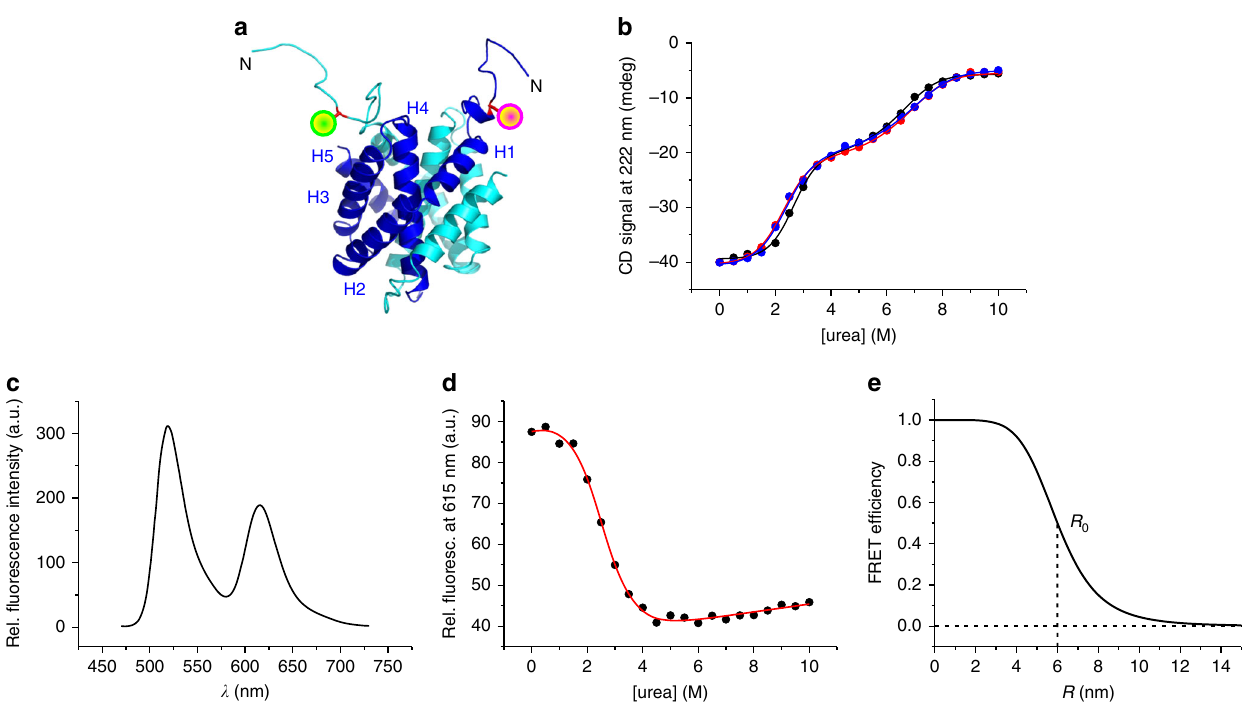
Fig. 2 Unfolding of N-terminal helices probed by FRET. a Homology model of the MaSp1 CTD from E. australis (template: pdb id 2KHM) shown in cartoon representation. Subunits of the dimer are depicted blue and cyan. Helices 1 – 5 of one subunit are indicated. Mutant side chain S14C at the N-terminal end of helices, which was site-speci fi cally modi fi ed with Alexa-Fluor-488 (green sphere) and Alexa-Fluor-594 (magenta sphere), is highlighted. b Chemical equilibrium denaturation of mutant C82A (red spheres) and mutant C82A – S14C (blue spheres) measured in pH 7.0 buffered solutions under nonreducing conditions. Denaturation data of wild-type CTD measured in pH 7.0 buffered solution under reducing conditions are shown for comparison (black spheres). Solid lines are fi ts to the data using a thermodynamic model for a three-state equilibrium involving a dimeric intermediate. c FRET spectrum of Alexa-Fluor- 488/Alexa-Fluor-594-modi fi ed CTD recorded in pH 7.0 buffered solution. Fluorescence was excited at 460 nm. d Chemical equilibrium denaturation of Alexa-Fluor-488/Alexa-Fluor-594-modi fi ed CTD probed by measuring Alexa-Fluor-594 fl uorescence emission intensities (black circles). The red line is a fi t to the data using the thermodynamic model for a two-state equilibrium. e Theoretical FRET ef fi ciency curve of the fl uorophore pair Alexa-Fluor-488/ Alexa-Fluor-594 plotted as function of intermolecular distance R . The Förster distance R 0 is